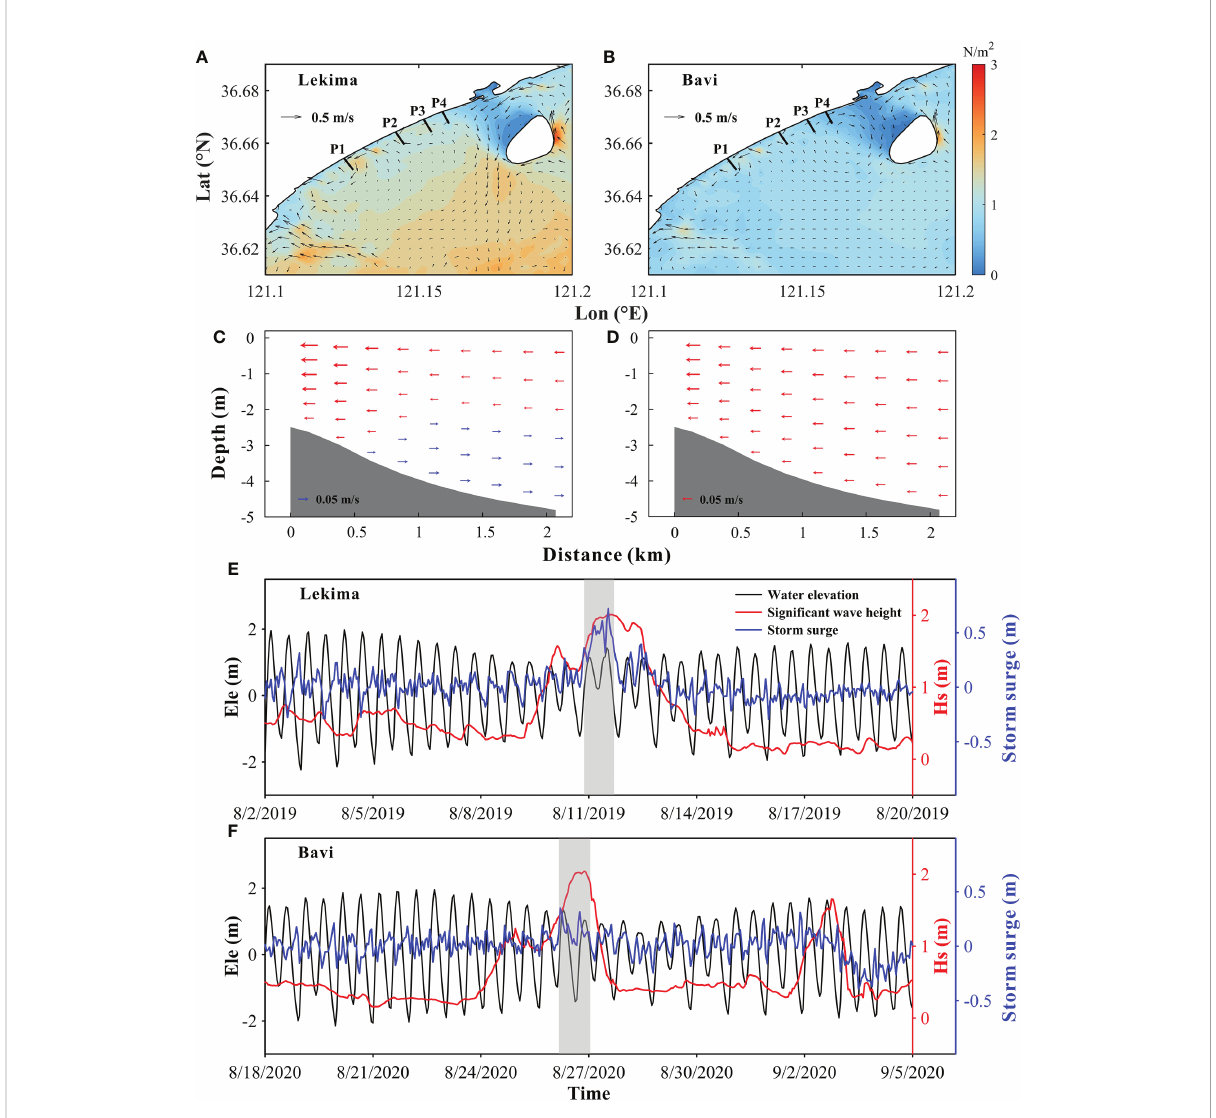
FIGURE 6 13h averaged surface residual currents (arrows) and bottom shear stress (colored) induced by Lekima (A) and Bavi (B) , respectively, and vertical distributions of residual currents at pro fi le P2 with red arrows indicated onshore and blue arrows indicated offshore during these two events (C, D) . Time series of simulated water elevation (black line), signi fi cant wave height (red line) and storm surge (blue line) at Station C2 during Lekima (E) and Bavi (F) , respectively. The gray areas represent the periods when storm surge were higher than 0.3 m and 0.1 m, respectively, which we refer to as the ‘ strong-effect period ’ of the two